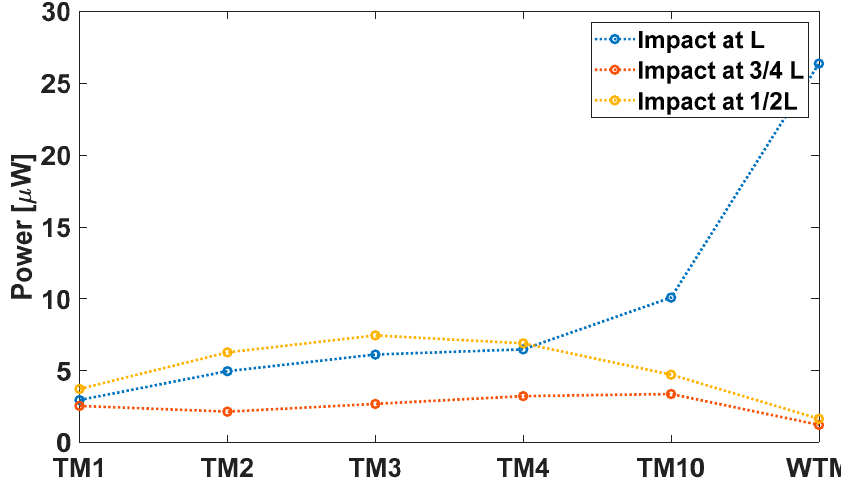
Figure 8. Average power plot of the parametric analyses for different values of tip mass placed on the transducer.